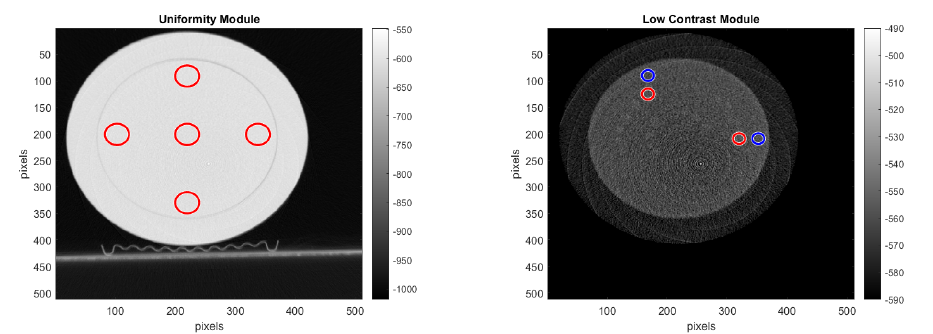
Figure 14. Uniformity module, placements of the